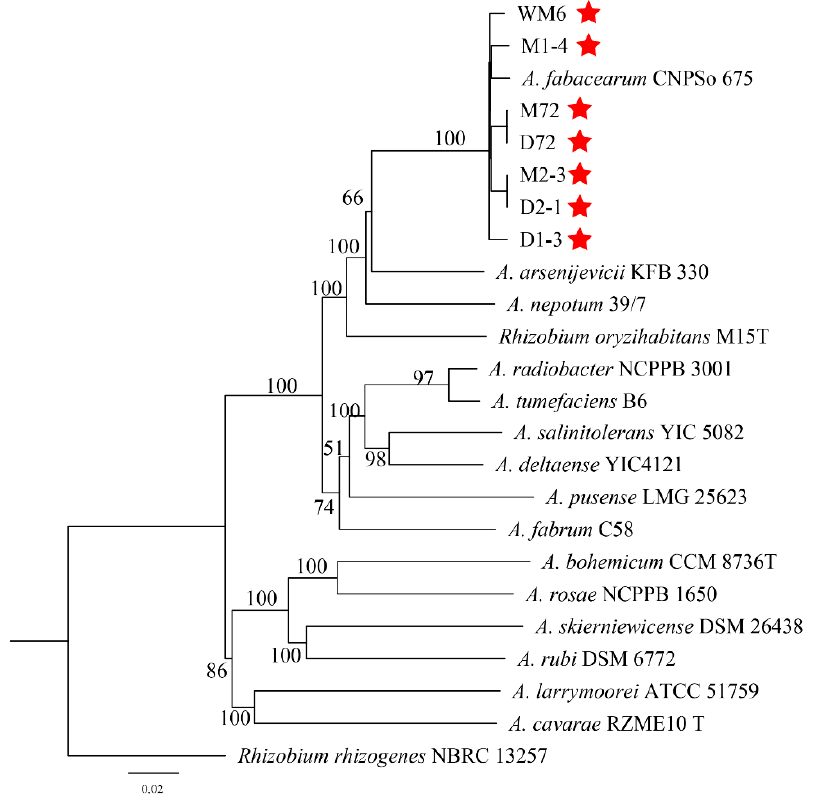
Figure 7. The GBDP tree (whole-genome sequence-based). Ex-type strains are marked by an asterisk.